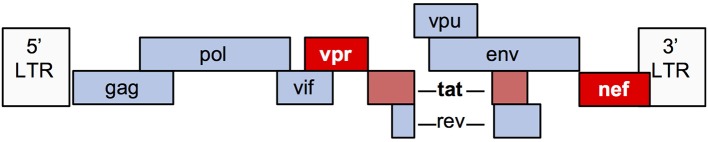
Schematic diagram of the HIV-1 genome.